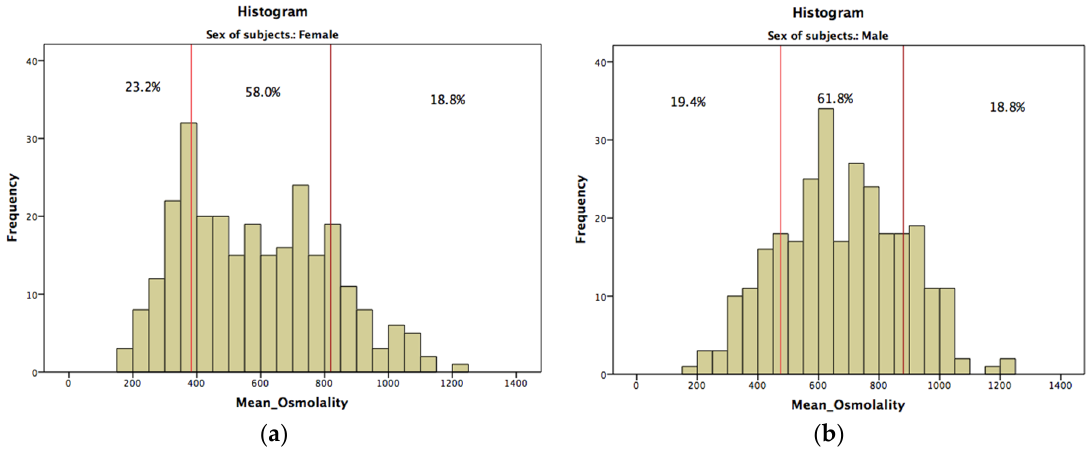
Figure 1. Distribution of hyperhydrated, euhydrated, and dehydrated ( a ) females and ( b ) males.